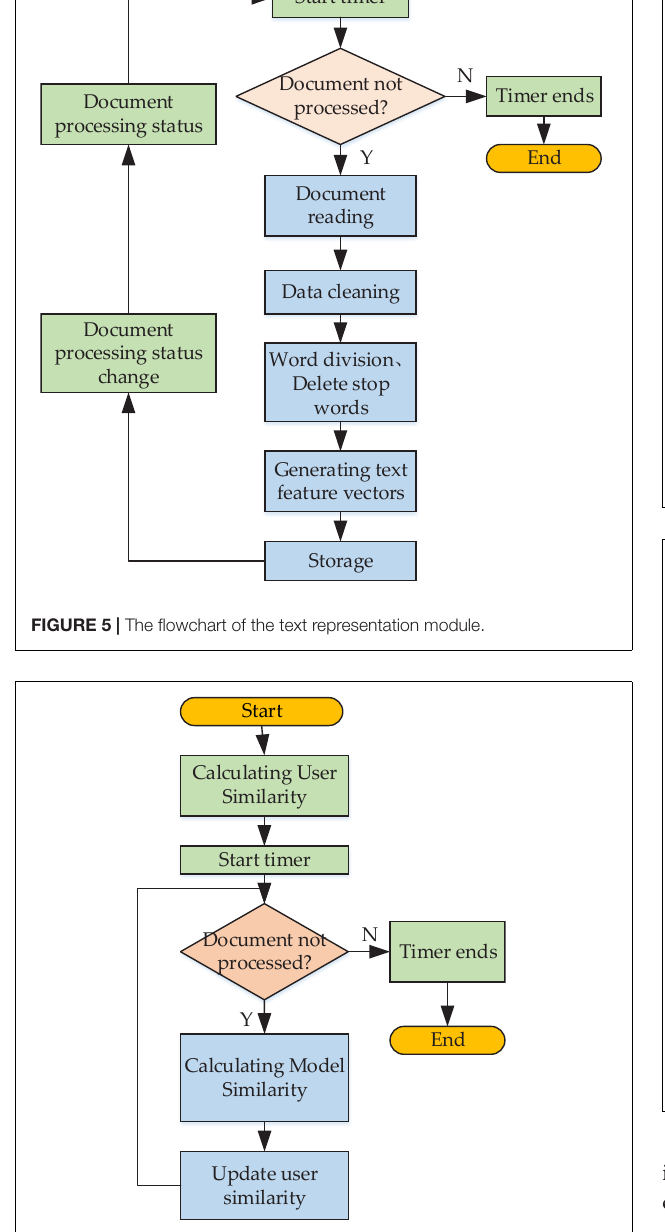
the algorithm is used for calculation and processing, the text data information is first obtained, the text data is initialized, and the key fields of the text, such as title, abstract, keywords, are extracted and processed, respectively. First, the text data are segmented, the stop words are deleted, and the weights of the fields are calculated separately. It is matched with the text information to be compared, the corresponding key-value pair